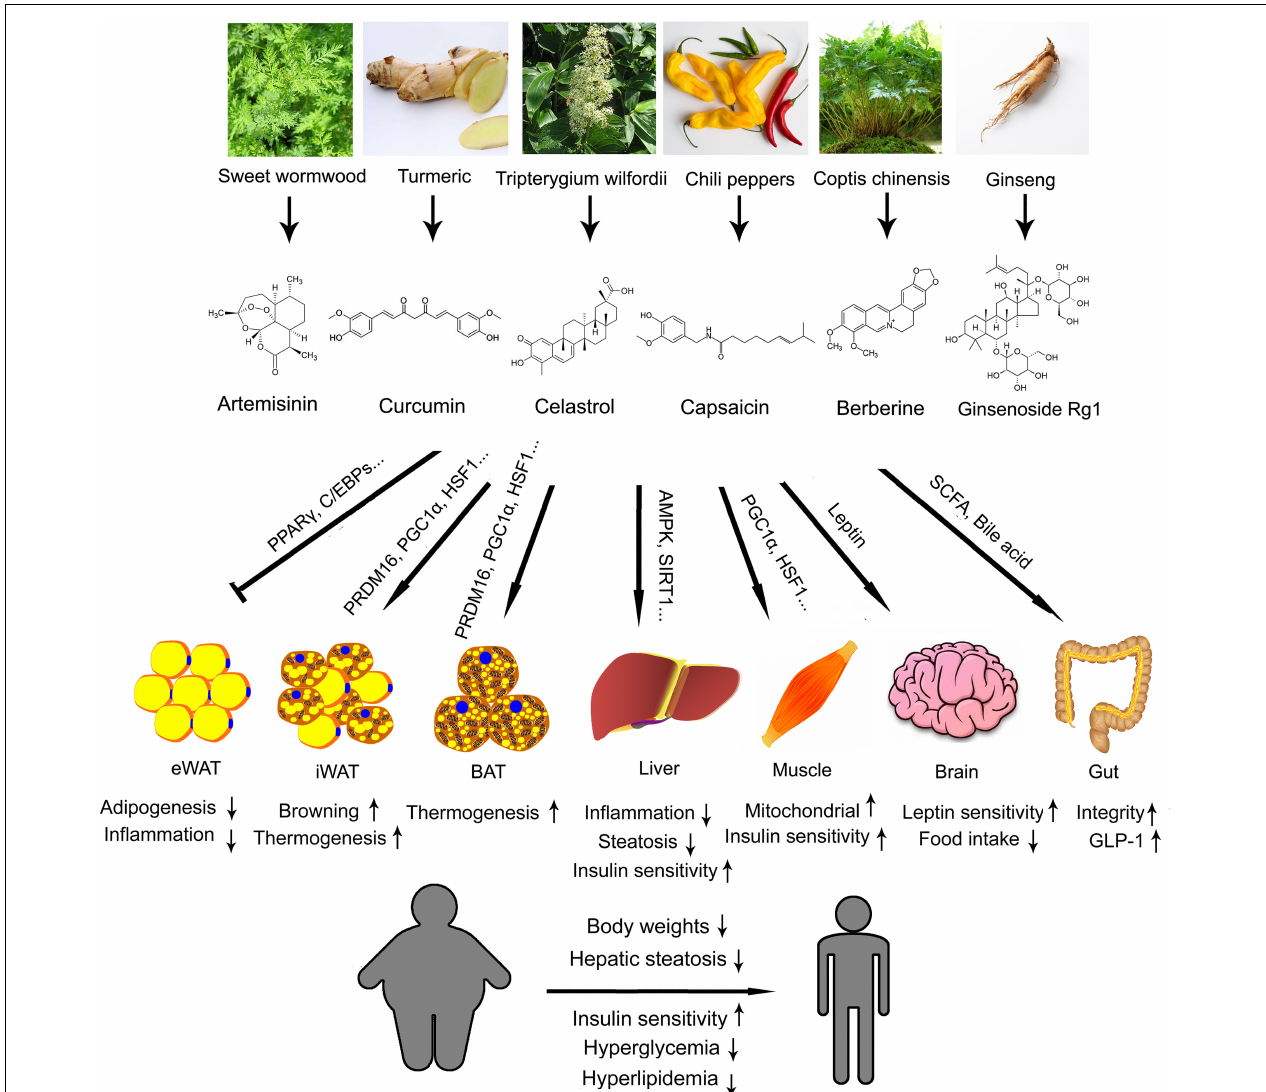
FIGURE 1 | Illustration summary of the original Traditional Chinese medicine (TCM) herbs, coumpound structures, metabolic effects and major mechanisms of artemisinin, curcumin, celastrol, capsaicin, berberine, and ginsenoside. eWAT, epidydimal white adipose tissue; iWAT, inguinal white adipose tissue; BAT, brown adipose